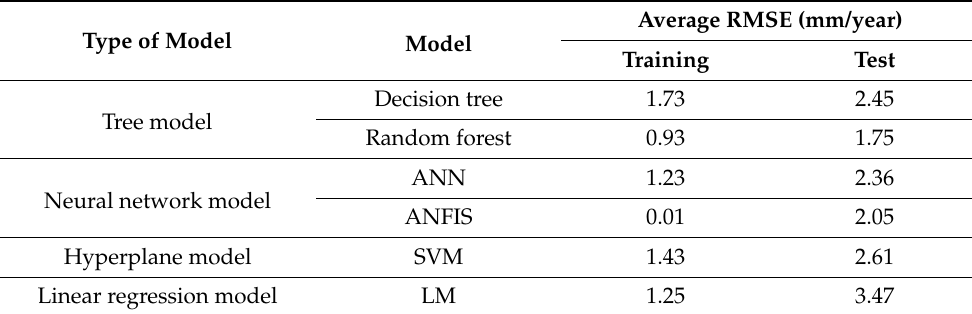
Table 4. The comparison of four types of machine learning (ML) models by the average RMSE (mm/year) values.